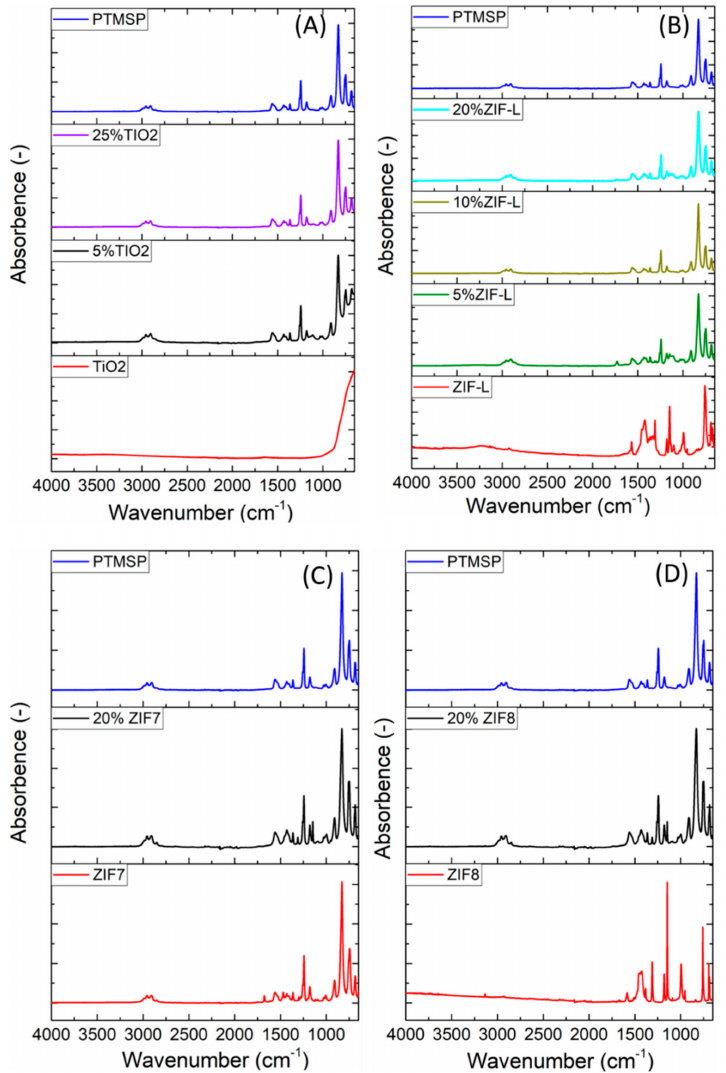
Figure 7. FT-IR spectrum of PTMSP/nanofiller hybrid membranes. ( A ) PTMSP/TiO 2 , ( B )PTMSP/ZIF-L, ( C ) PTMSP/ZIF-7 and ( D )